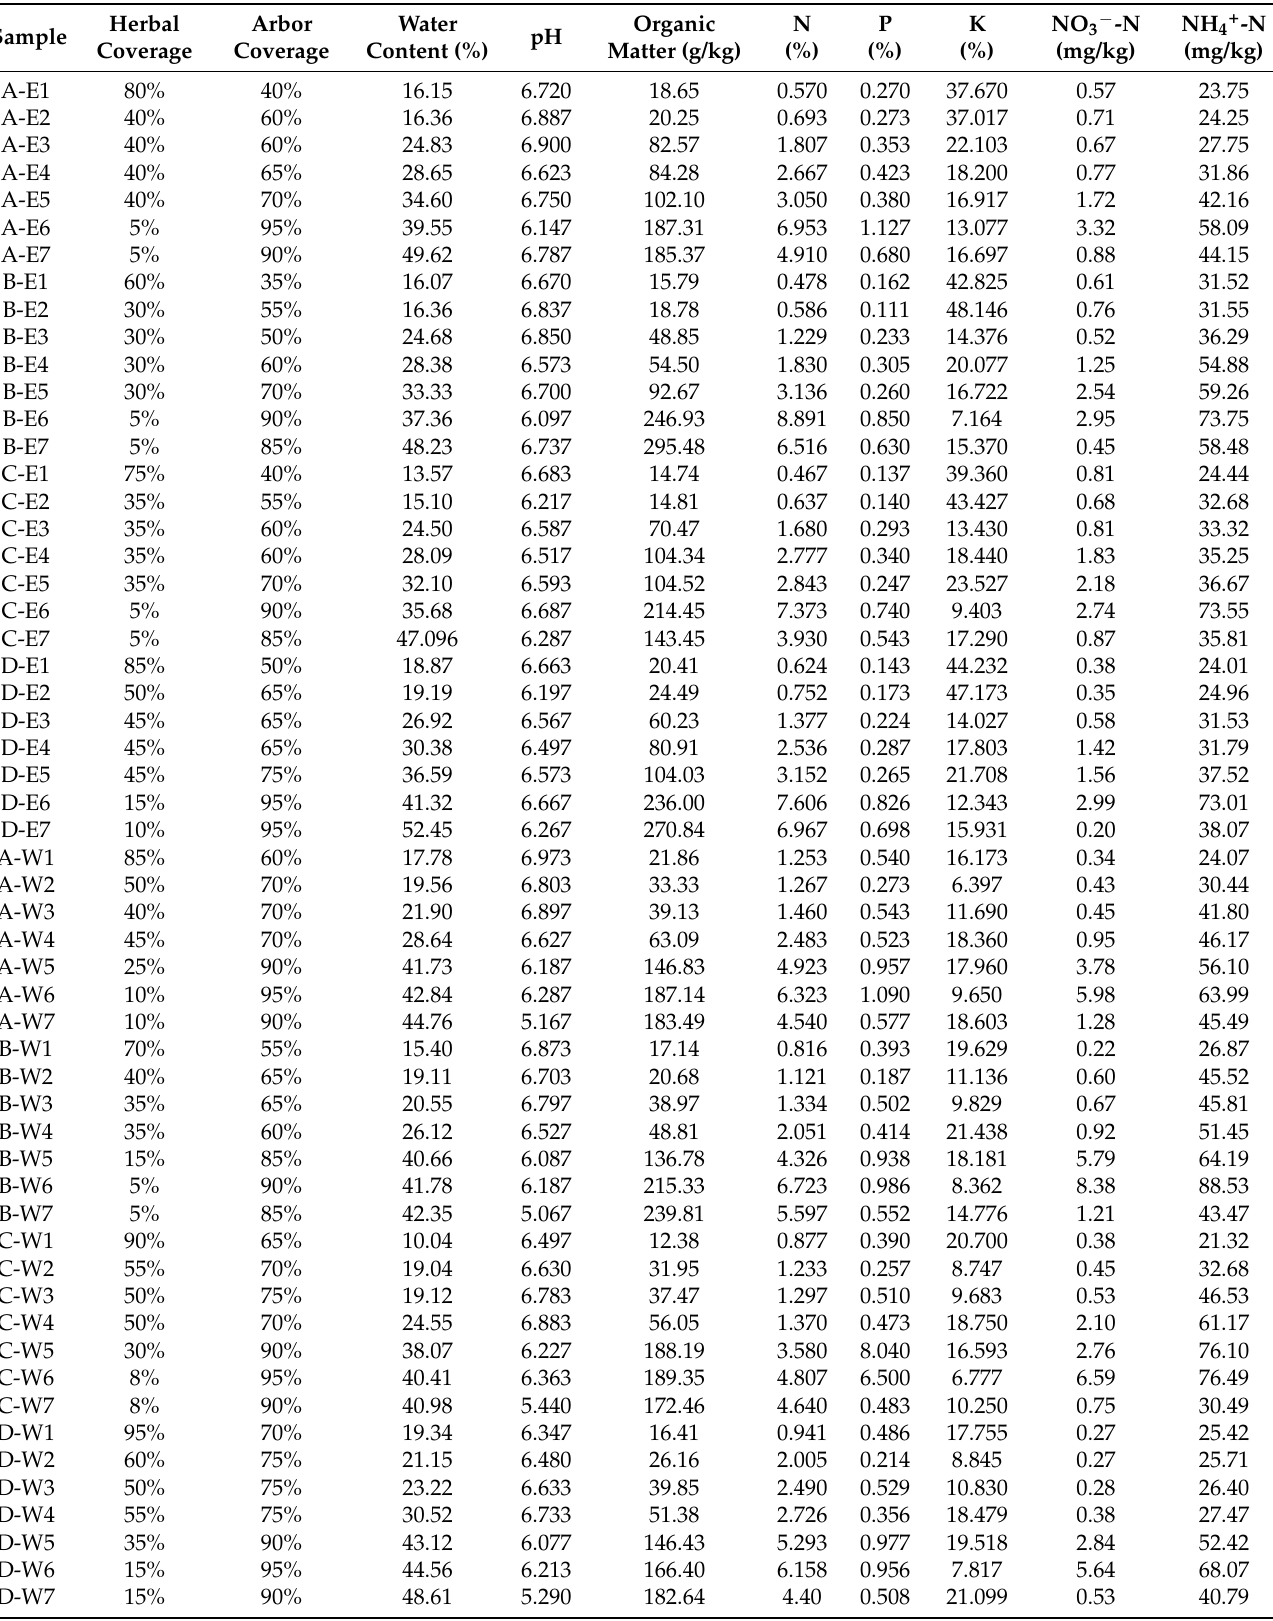
Table 2. Soil physical and chemical